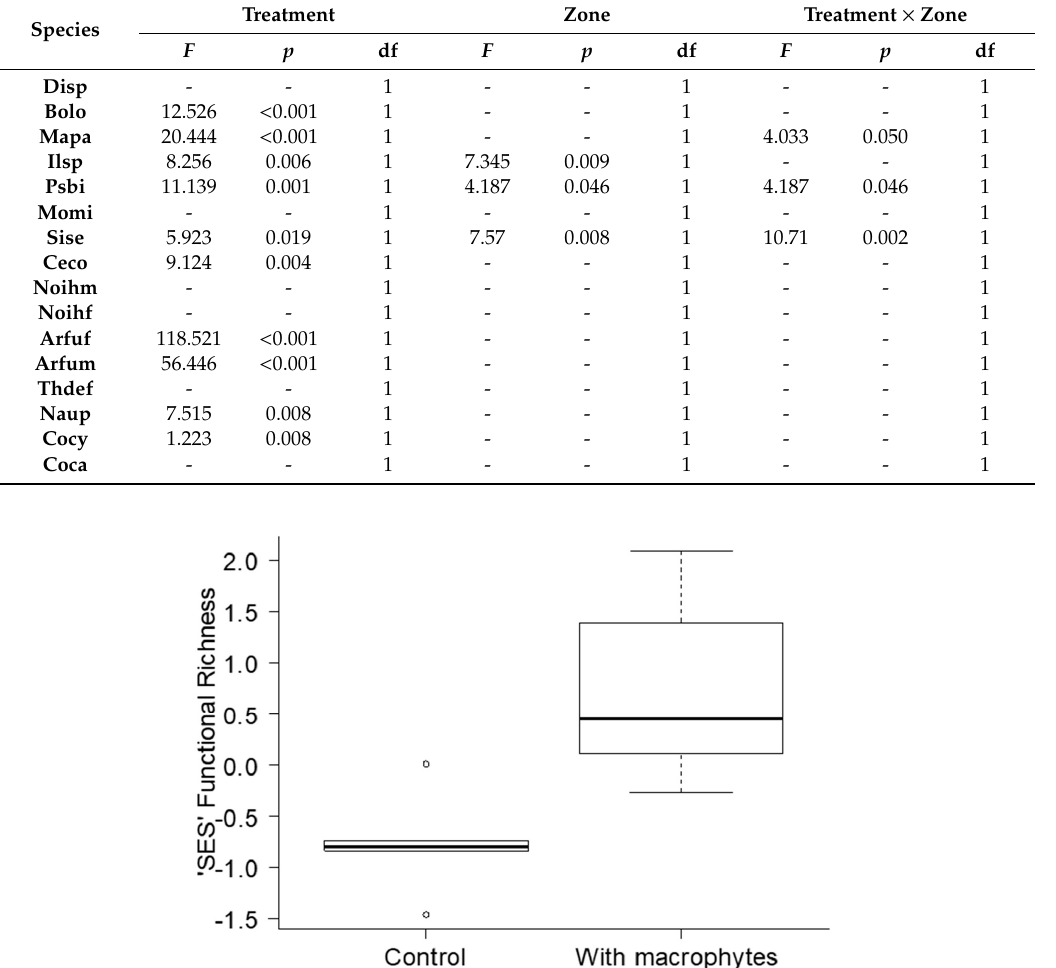
Table 4. Two-way ANOVA results comparing log species density by treatment (with macrophytes and control), by zone (littoral and pelagic), and for the interaction of treatment and zone. Trait abbreviations as in Table 2.